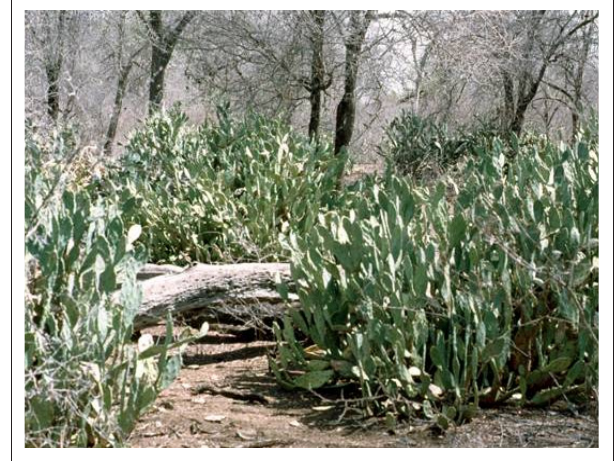
FIGURE 1: Invasion with less than 10 % cover.